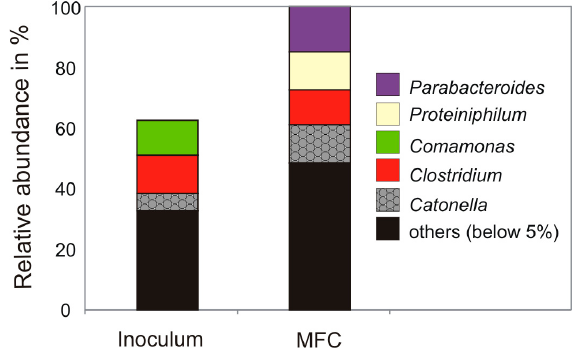
Figure 5. Relative abundance of dominating bacteria genera in fresh inoculum and after work in MFC system.